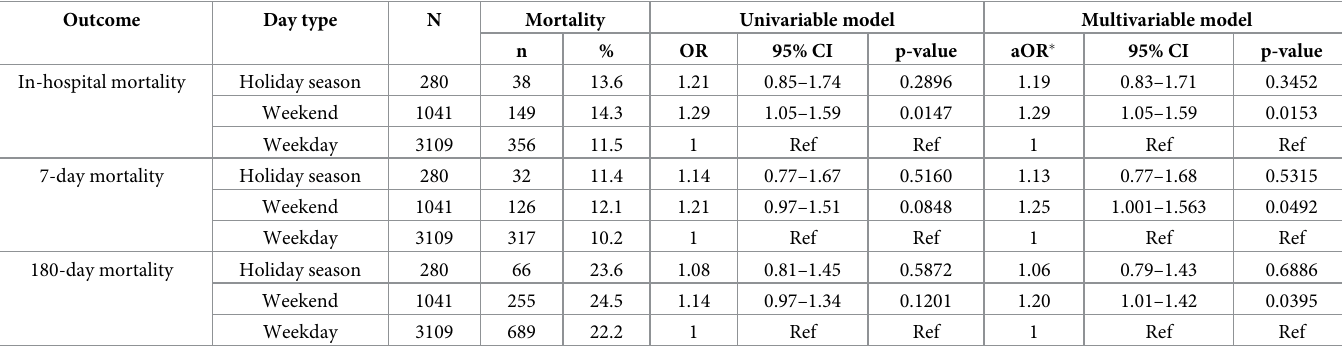
� The aOR is calculated by multivariable logistic regression model with adjustments for the characteristics listed in Table 1 (including age, sex, income level, aortic dissection type, hospital level, hospital area, Charlson comorbidity index score, and comorbidities). Abbreviations: n, number; OR, odds ratio; aOR, adjusted odds ratio; CI, confidence interval; Ref, reference